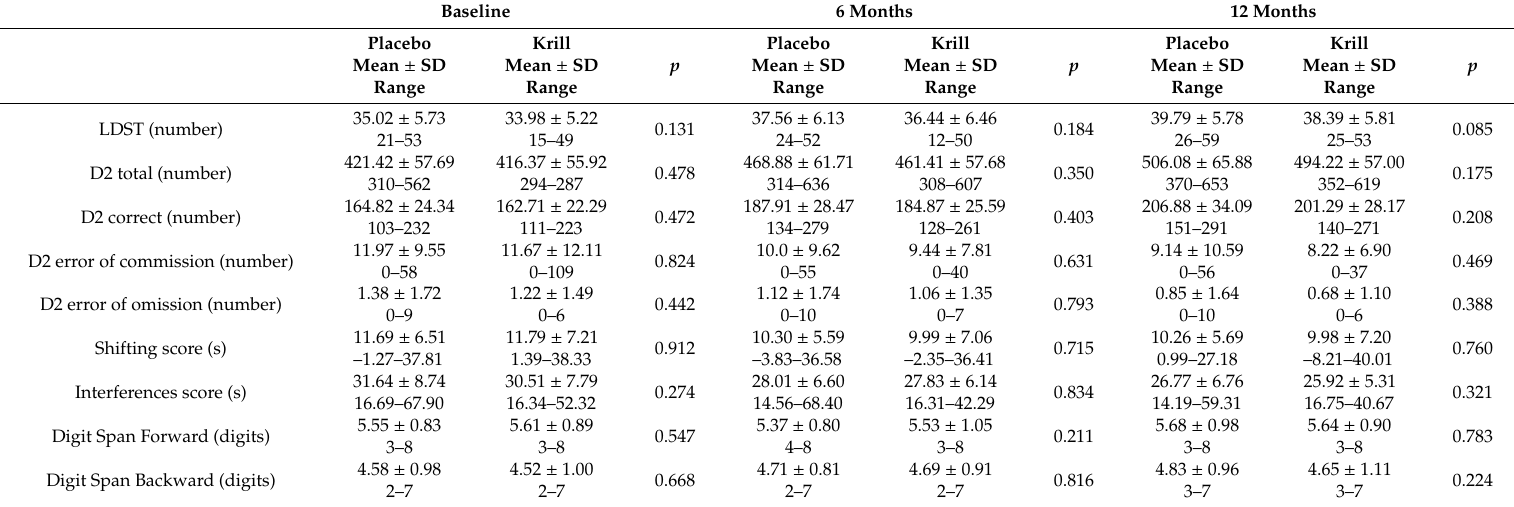
Table 3. Scores on the cognitive tests at di ff erent test moments in intention-to-treat analysis.